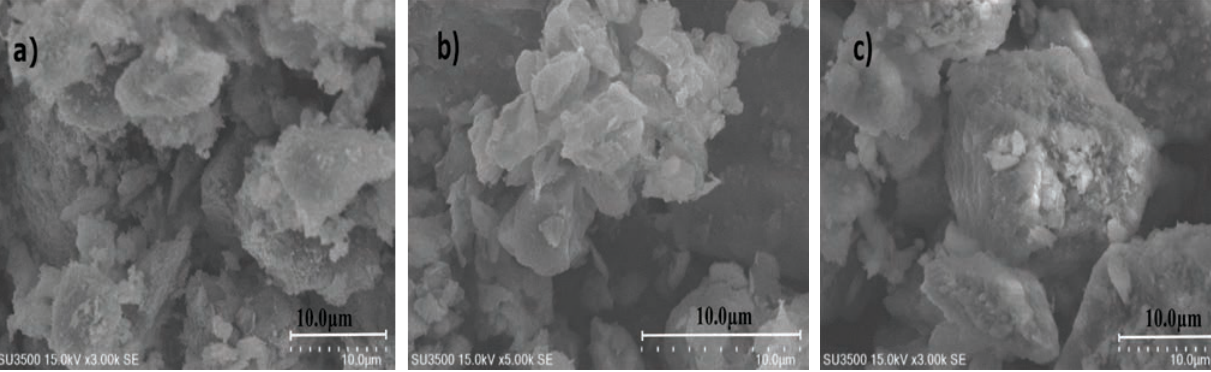
Fig. 2. SEM images of the natural minerals, (a) TUSH-ZEO; (b) TUSH-CLA and (c)